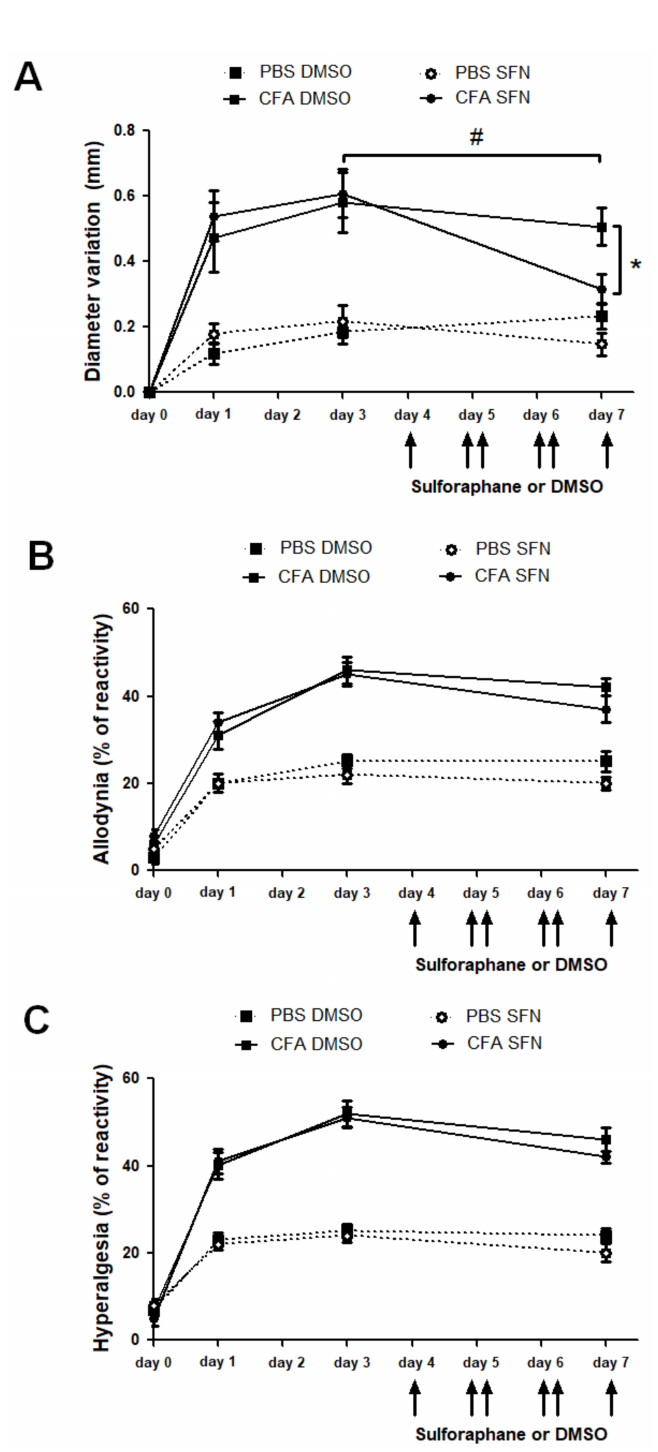
Figure 1. Effects of sulforaphane in the mechanical nociception and knee joint thickness of mice with mono-arthritis. Injection of CFA (10 µ L ipsilateral knee) and PBS (10 µ L in the contralateral knee) was performed at day 0. ( A ) Variation (mm) of knee diameter (joint oedema) was measured at days 0 (prior to injection), 1, 3 and 7. Secondary allodynia ( B ) and mechanical hyperalgesia ( C ) were measured by percentage of paw withdrawal reflex relative to stimulation with Von Frey filaments 0.4 and 0.6 g, respectively. Six consecutive doses of SFN or DMSO were injected i.p. every 12 h starting at 7:00 a.m. on 4th day. Data are expressed as mean ± SEM. Experiments were performed in four different occasions ( n = 14 animals per group). * # p <